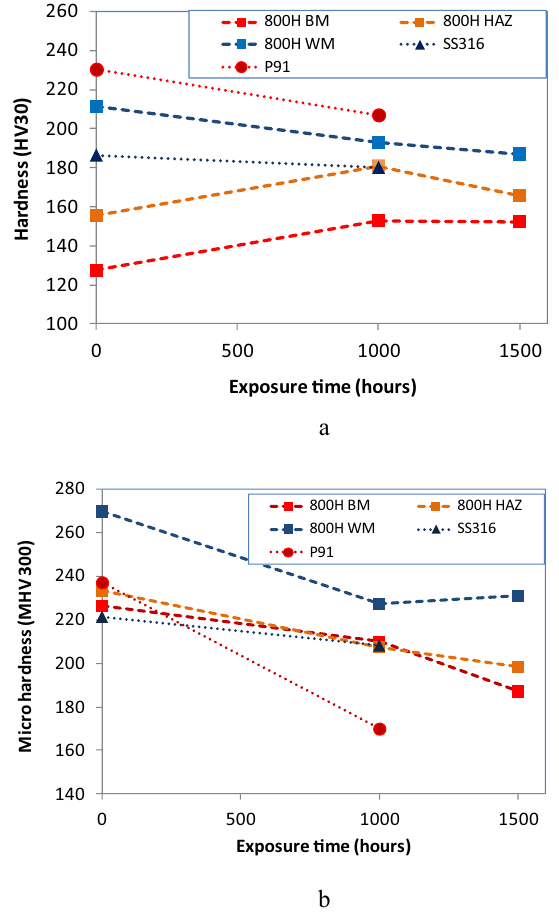
Fig. 10. (a) hardness, (b) micro hardness of tested alloys depending on exposure time in impure helium at 750 – 760 °